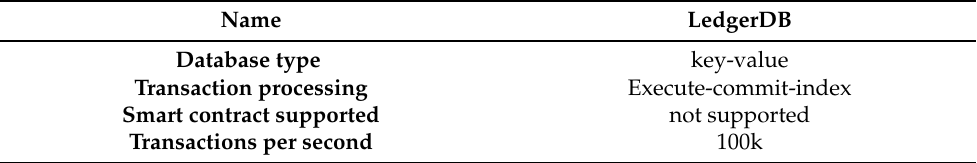
Table 1. Overview of discussed Centralised Ledger Technology.